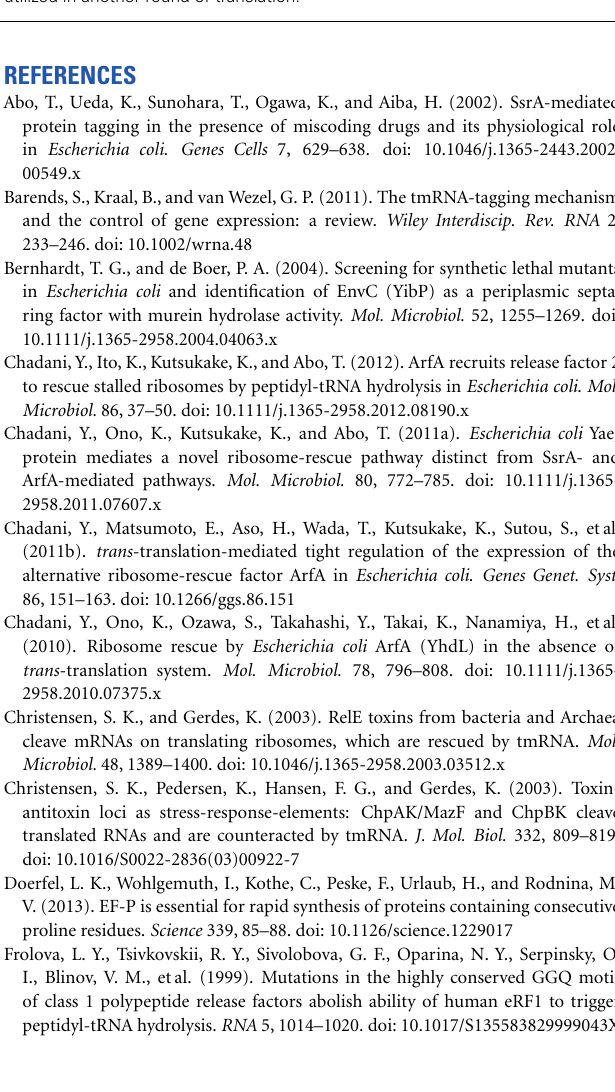
least three ribosome rescue systems mediated by tmRNA–SmpB complex, ArfA, or ArfB. In either case, NTC is resolved and rescued ribosome can be utilized in another round of